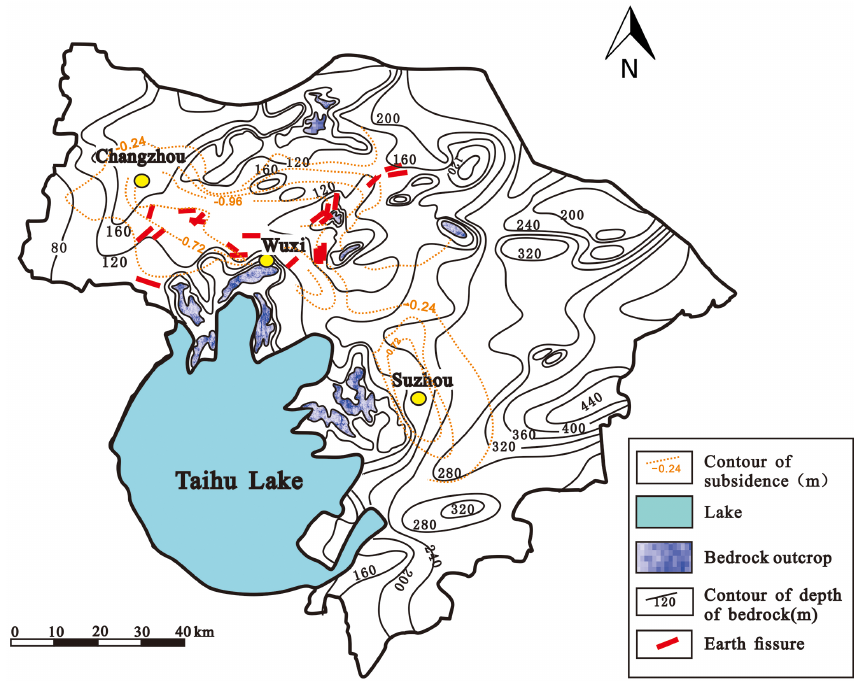
Figure 1. The distribution of earth fissures in Su-Xi-Chang area. The bedrock outcrops and depth (m from the mean sea level) and the cumulative land displacement from 1980 to 2000 are mapped (after Liu et al., 2004).